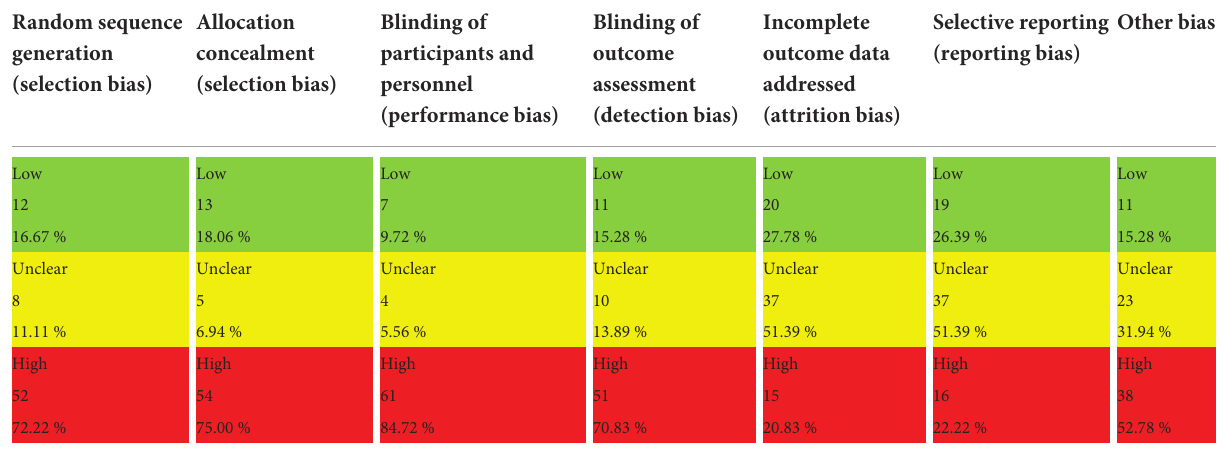
TABLE 1 Risk of bias.